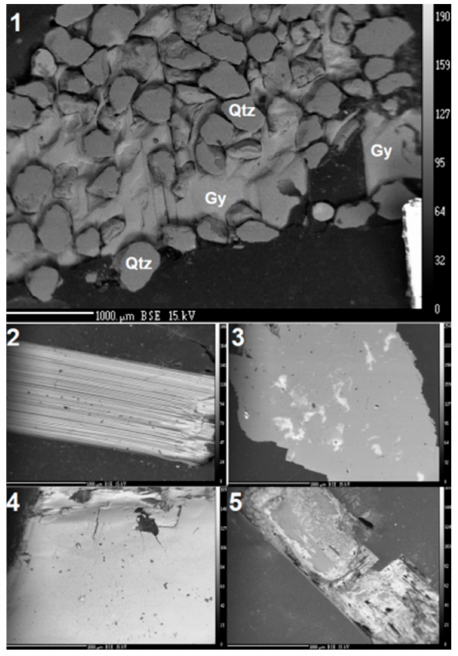
Figure 2. Electron microscope (SEM) images of the samples used in the present study which include: 1: Desert Rose Gypsum, Sahara Desert, Morocco (MDRG), Gypsum, Gy, and quartz, Qtz, are identified. 2: Acicular Gypsum, Morocco (MAG). 3: Gypsum, Kachchh, Gujarat, India (KG). 4: